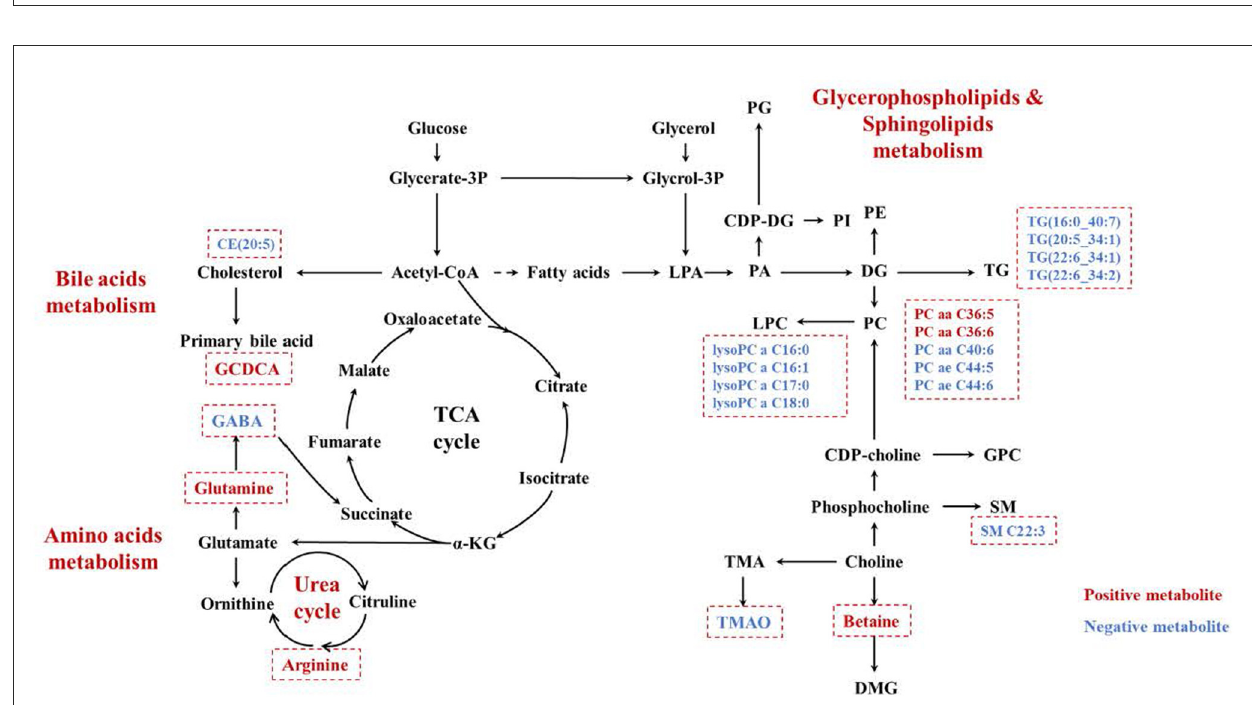
FIGURE3 The increased metabolites were marked in red, while the decreased ones were marked in blue. PG, polygalacturonase; CDP-DG, cytidine 5’-diphosphate 1,2-diacyl-sn-glycerol; LPA, lysophosphatidic acid; PA, phosphatidic acid; PI, phosphoinositide; PE, phosphatidylethanolamine; DG, diacylglycerol; PC, phosphatidylcholine; LPC, lysophosphatidylcholine; TG, triglyceride; GPC, l- α - Glycerophosphatidylcholine; SM, sphingomyelin; DMG, dimethylglycine; TMA, trimethylamine; TMAO, trimethylamine N-oxide; PM 2.5 , PM with particle diameter < 2.5 µ m.